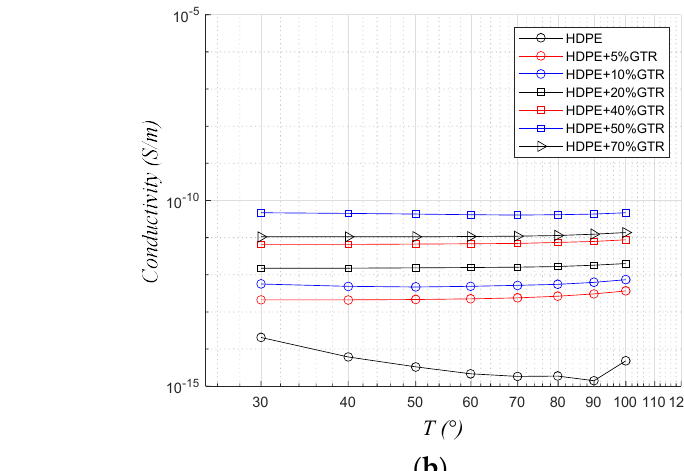
Figure 4. Thermal response of the conductivity with a temperature range of 30 to 100 °C, at 50 Hz, of ( a ) LDPE/GTR compounds and ( b ) HDPE/GTR compounds.